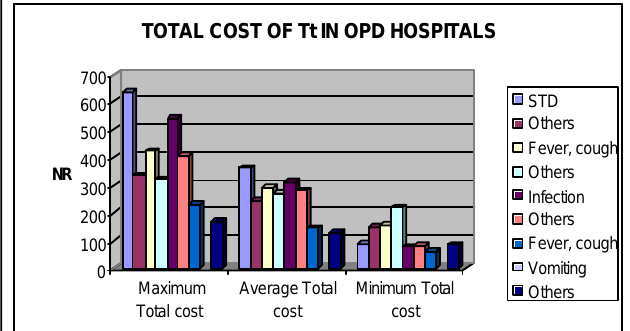
Table V. Showing percentage of antibiotic prescribed after